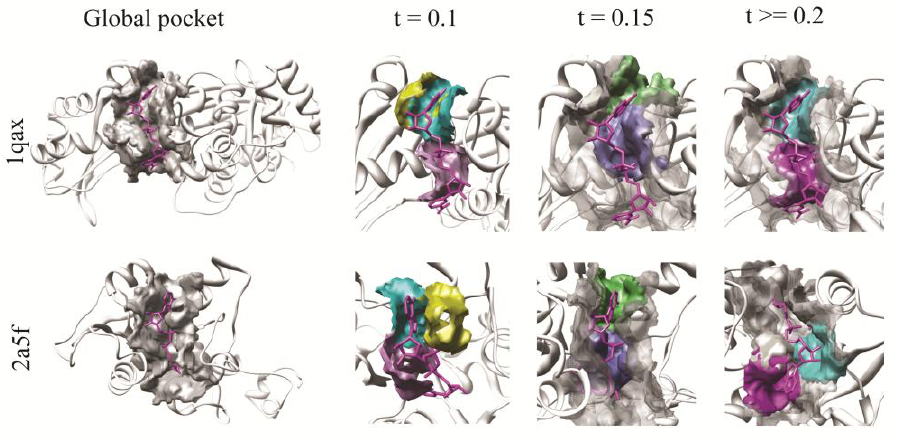
matched patch pairs using the distance threshold, td , of 0.1; 24 matches using td = 0.15, and 34 matches using td ≥ 0.2. Each matched pair of patches between pockets in PDBID:1qax and PDBID:2a5f are marked with the same